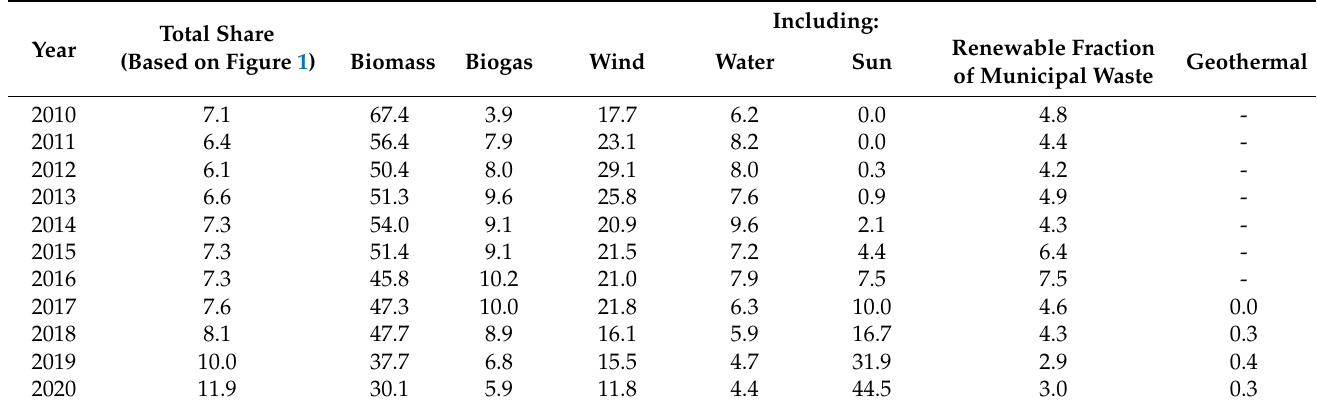
Table 1. Share of electricity produced from renewable energy sources in Hungary by energy type, 2010–2020 (%)